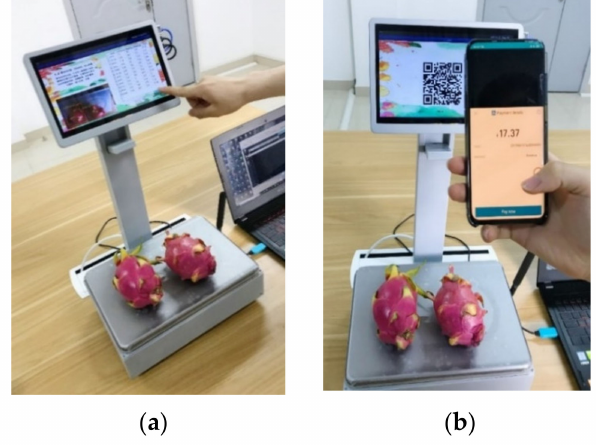
Figure 14. The payment process of the intelligent self-service vending system. ( a ) Click the checkout button; ( b ) pay with Alipay application.